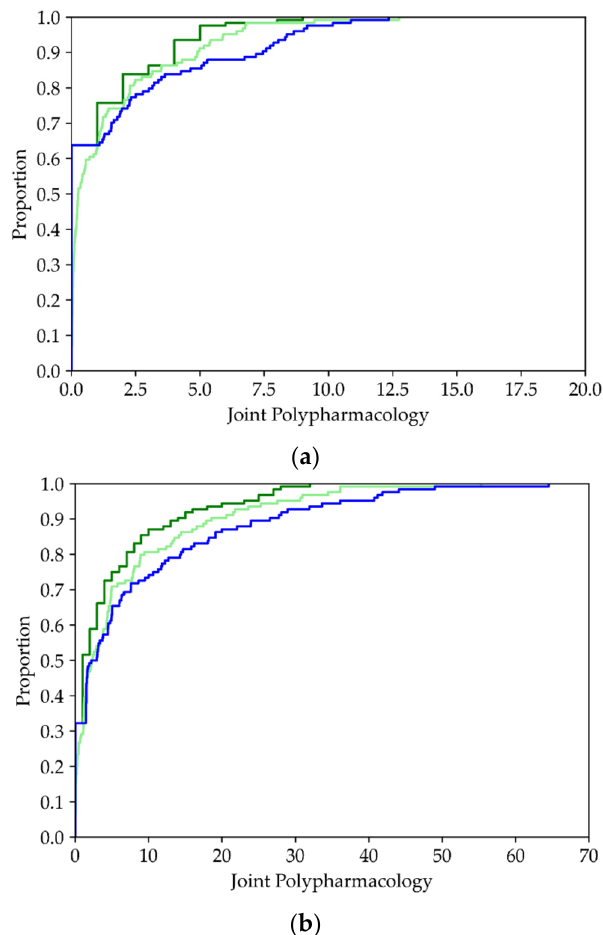
Figure 12. Cumulative distributions of estimated joint polypharmacologies for the exemplary ligands ( a ) CHEMBL119385 and ( b ) CHEMBL288441. The dark green line shows the cumulative distribution for the minimum joint polypharmacologies, the lime green for the estimated joint polypharmacologies assuming independence of activity for both ligands, and the blue line represents the estimate based on the observed joint polypharmacologies for non-null LT pairs.